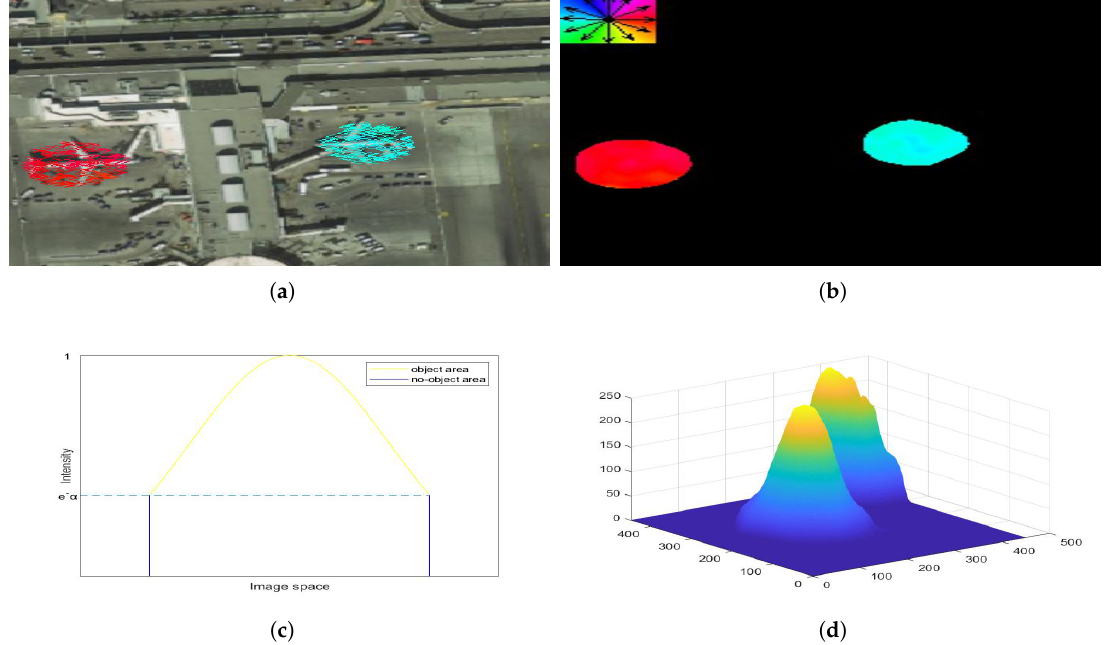
Figure 3. Intensity distribution of object in the field. ( a ) is the direction diagram, ( b ) is the Direction Field. ( c ) is the two-dimensional graps of the Center Field. ( d ) is the three-dimensional graph of the Center